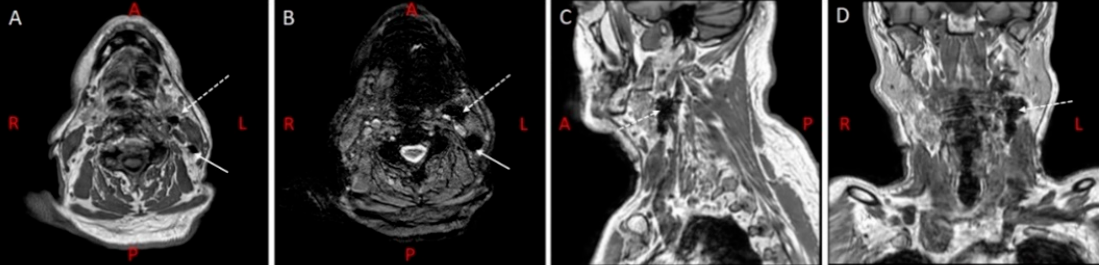
Figure 4. MR lymphography using superparamagnetic iron oxide nanoparticles in a 77-year-old man with oral tongue cancer and a clinically negative neck. ( A ) T1-weigted 3D fast-field echo (FFE) show uptake of SPIO in two SLNs in level IIa (dotted arrow) & level IIb (arrow) left. ( B ) T2-weighted FFE shows clear negative contrast in corresponding SLNs, as a result of SPIO uptake. ( C , D ) Sagittal and coronal reconstruction of ( A ) shows the SLN in level IIa left (dotted arrow). ( A – D ) Informed consent has been obtained from this patient.